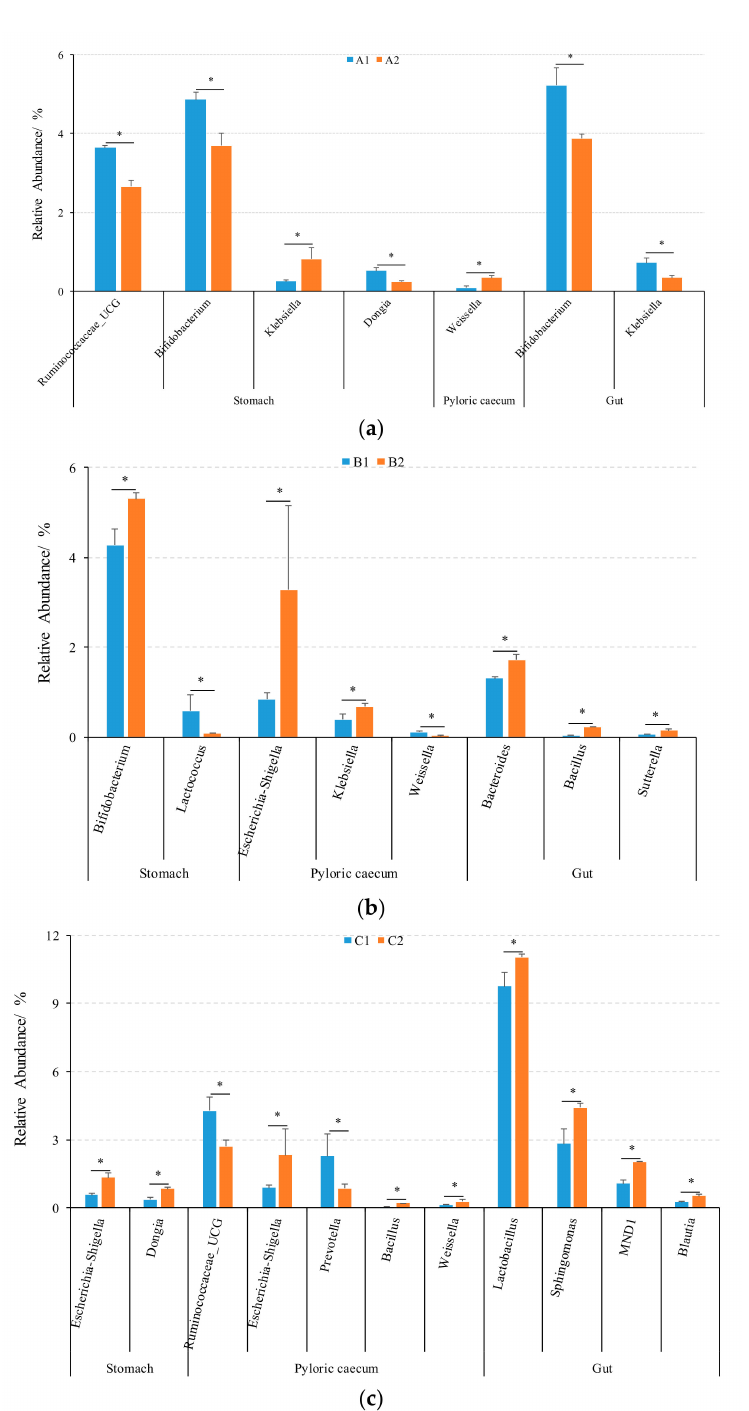
Figure 5. The dominant genera with significant differences in the gastrointestinal tract of yellow- tail kingfish. Notes: ( a ) between the beginning and end of the study for the low-density group; ( b ) between the beginning and end of the study for the medium-density group; ( c ) between the beginning and end of the study for the high-density group. A1, B1, and C1 represent the low-, medium-, and high-density groups at the beginning of the study, while A2, B2, and C2 represent the low-, medium-, and high-density group at the end of the study. * represents the significant differences between the beginning and end of the study in each density group ( p ≤